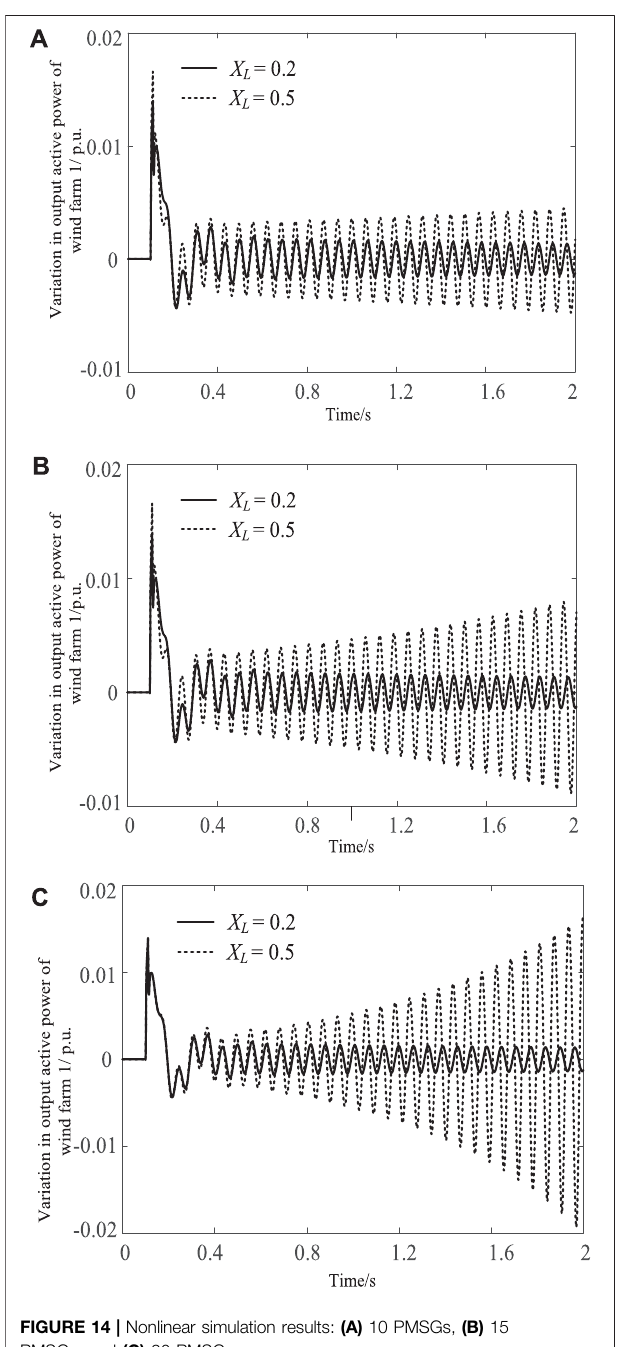
FIGURE 14 | Nonlinear simulation results: (A) 10 PMSGs, (B) 15 PMSGs, and (C) 20